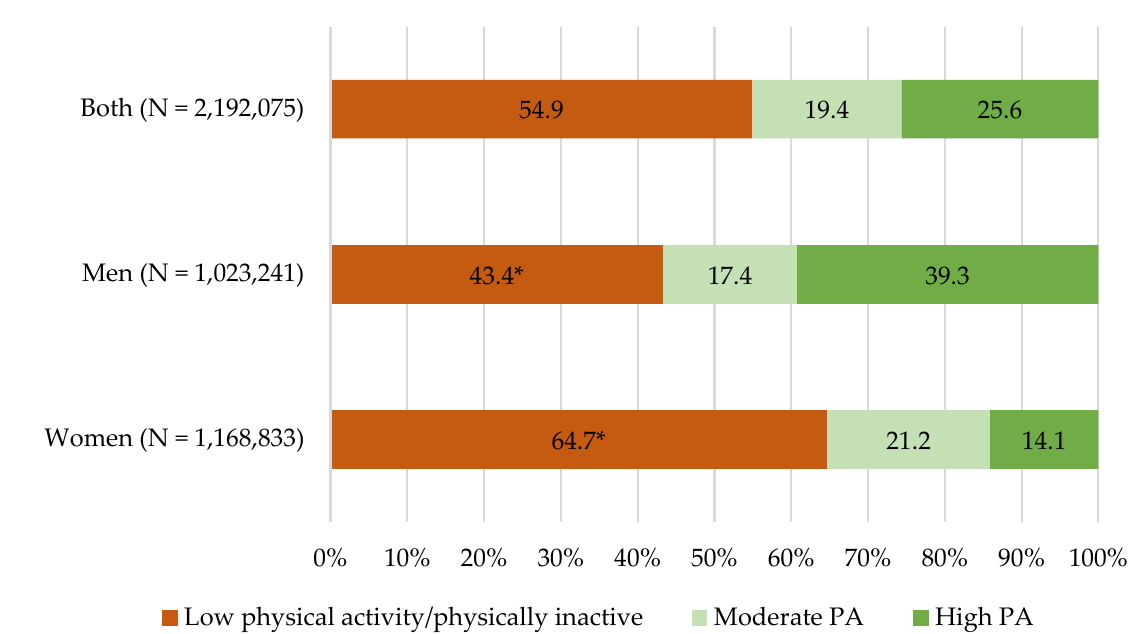
Figure 2. Weighted standardised prevalence of the low physical activity category/physically inactive and physical activity (PA) categories by sex among participants aged 18–69 years. Panama, 2019. * p -value < 0.001.